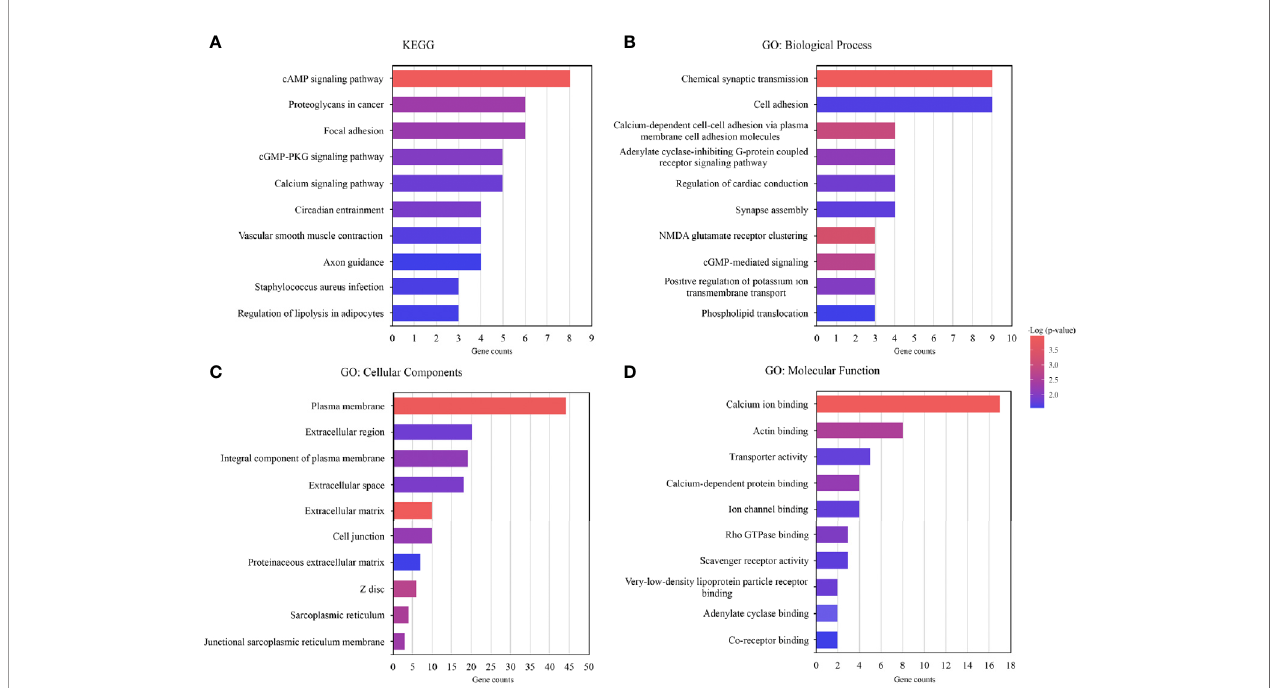
FIGURE 5 | Functional annotation of the genes with differential expression in the two subgroups. (A) Functional annotation of the differentially expressed genes (DEGs) using Kyoto Encyclopedia of Genes and Genomes (KEGG) pathway. (B – D) Functional annotation of the DEGs using Gene Ontology (GO)